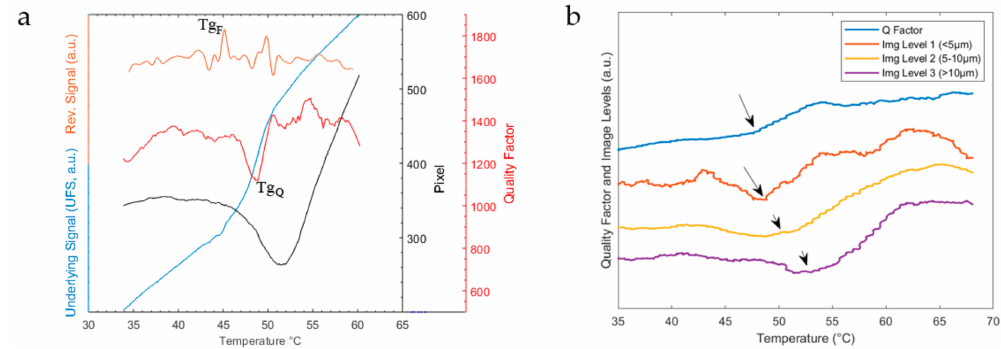
Figure 6. ( a ) Micromechanical Thermal Analysis (MTA) responses of the underlying frequency signal (light blue), the reversing signal (orange), and quality factor (red) as well as the response from the 2D image analysis of level 2 as pixel count (black) during the glass transition process. Tg F marks the Tg as detected by the local maximum in the reversing signal, and Tg Q marks the Tg as detected by the quality factor minimum. ( b ) Image contour levels obtained from the image analysis and the quality factor from another measurement example. The main slope onsets during the glass transition are marked with an arrow,